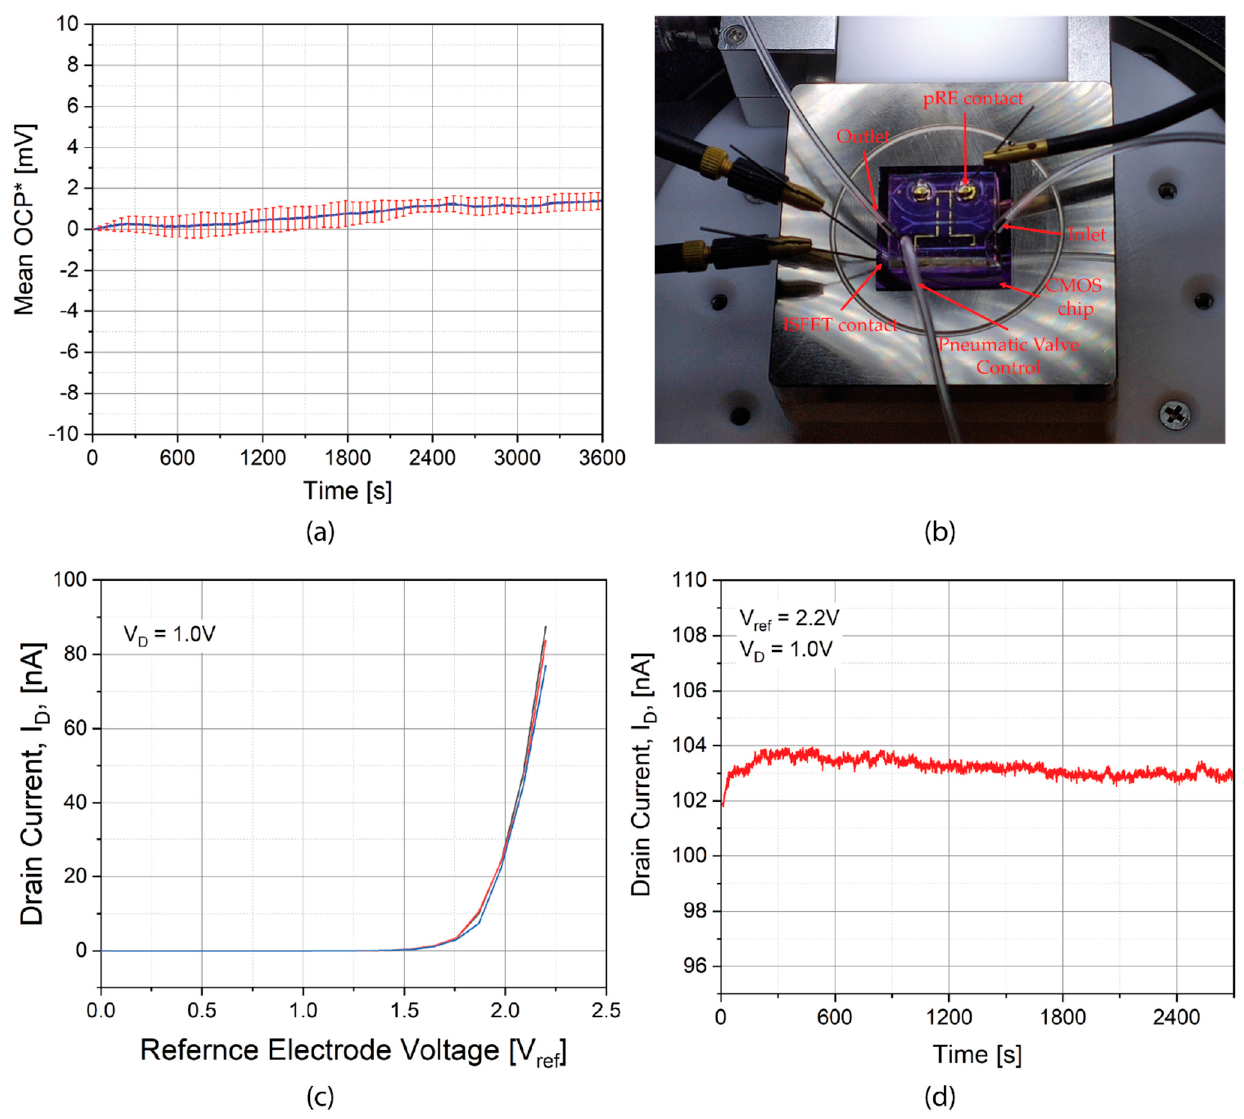
Figure 6. ( a ) Mean OCP (*offset to zero at t = 0) drift of pseudo-RE for three measurements in 3M KCl over a period of an hour. ( b ) Characterization setup showing fluidic conduit, pneumatic valves, and pseudo-RE contact. ( c ) I D -V ref characteristics (three repetitions) of electrolytically gated Silicon nanowire ISFET in presence of 3M KCl. ( d ) ISFET static response over time in 3M KCl solution. Estimated drain current drift: ~1 nA/h.